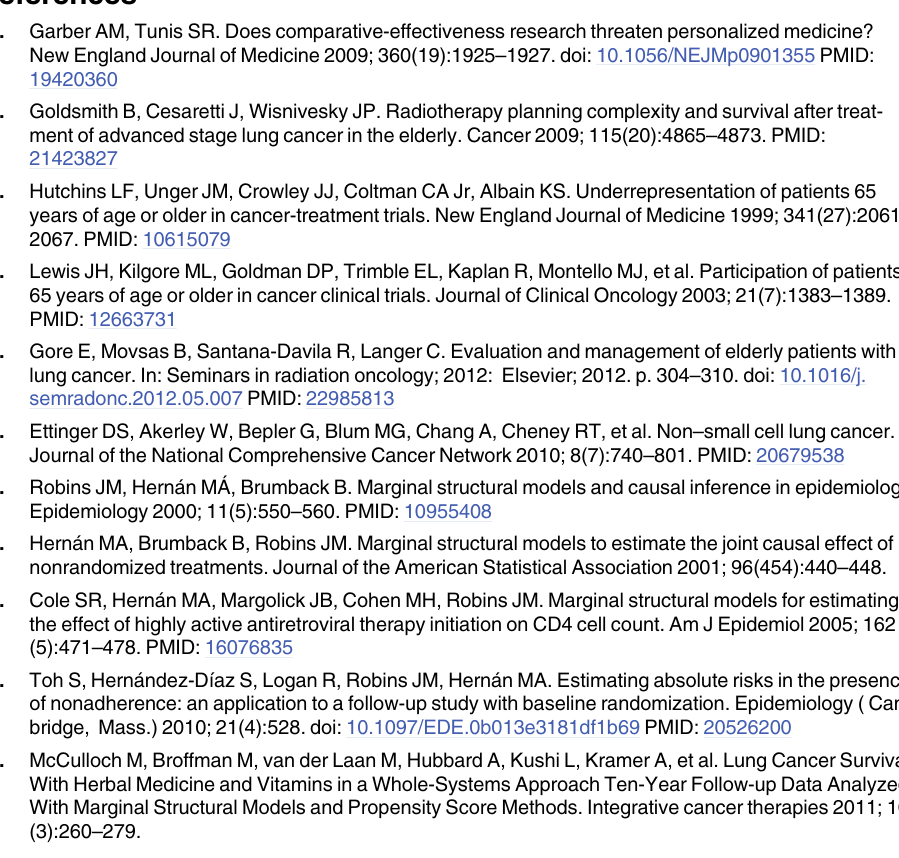
S1 Table. The numbers of patients in treatment groups and percentage calculated without the IP weights and p-values of the χ 2 -tests for treatment-group comparison of stage-specif- ic cohorts of lung cancer patients calculated for original populations. S2 Table. The numbers of patients in treatment groups and percentage calculated with the IP weights and p-values of the χ 2 -tests for treatment-group comparison of stage-specific co- horts of lung cancer patients calculated for pseudorandomized populations. S3 Table. The p-values of the χ 2 -tests for treatment-group comparison of stage-specific co- horts of lung cancer patients calculated for original and pseudorandomized (i.e., weighted) populations in specific times after